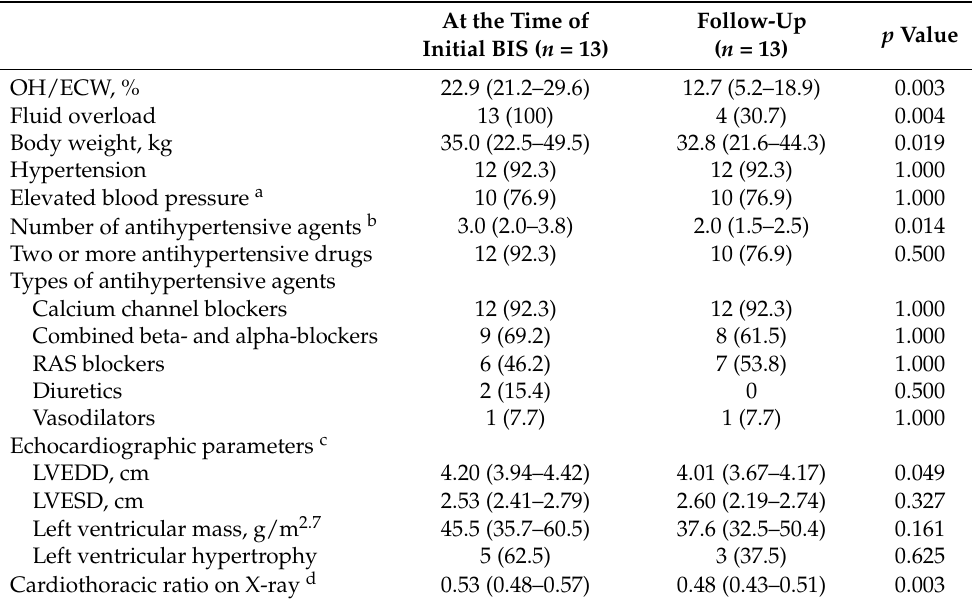
Table 3. Changes in the clinical parameters in children with fluid overload after the change of dialysis